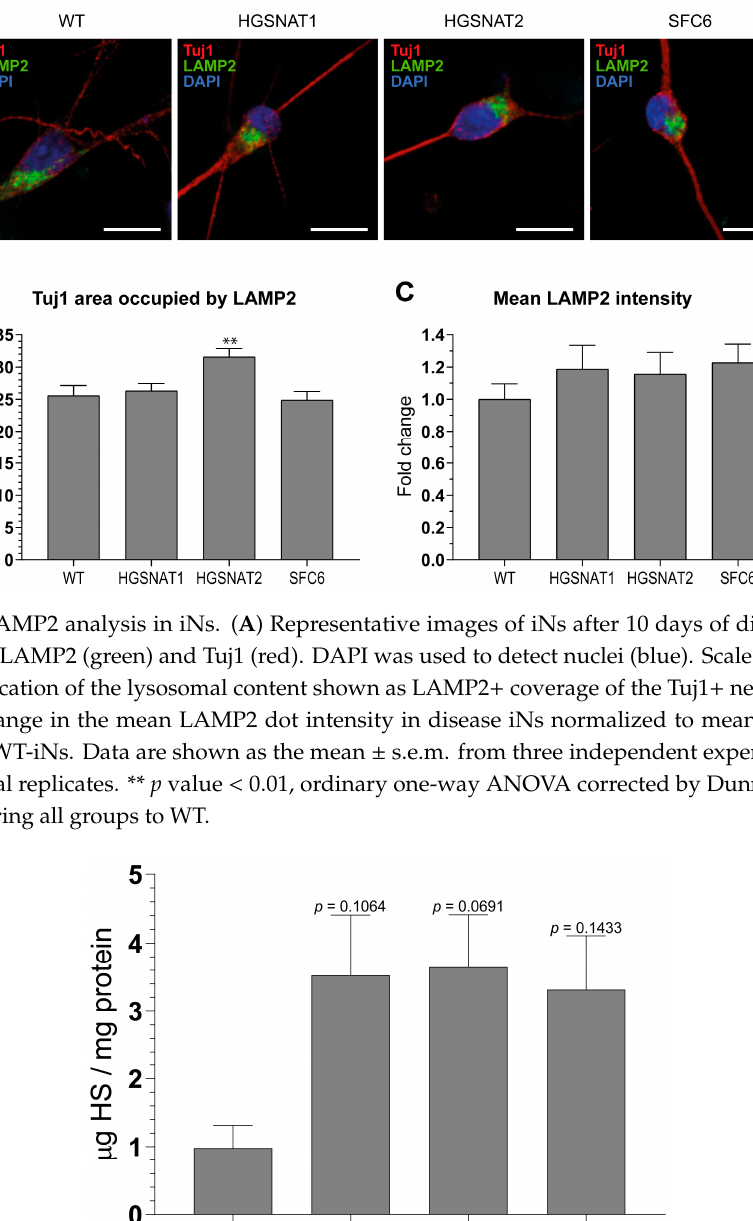
Figure 5. HS quantification by ultra-performance liquid chromatography–tandem mass spectrometer (UPLC-MS/MS) in iNs derived from all iPSC lines: WT, HGSNAT1, HGSNAT2, and SFC6. HS quantity is expressed in µg of HS in relation to mg of total protein. Data are shown as mean ± s.e.m. from three independent experiments with two technical replicates. One-way ANOVA corrected by Dunnett post hoc test, comparing all groups with the WT.